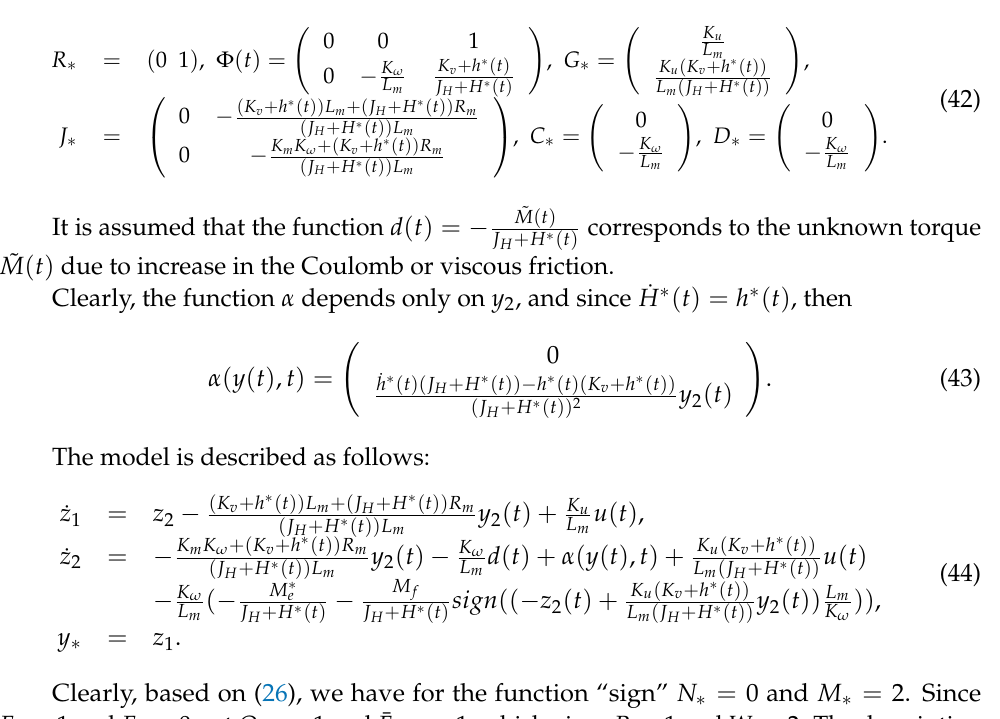
Figure 1. Kinematic scheme of manipulator: m i is the mass of i -th link; l i is the length of i -th link; l ∗ is the distance from the rotation joint of i -th link to its center of mass; and m t is the mass of the load (tool in the